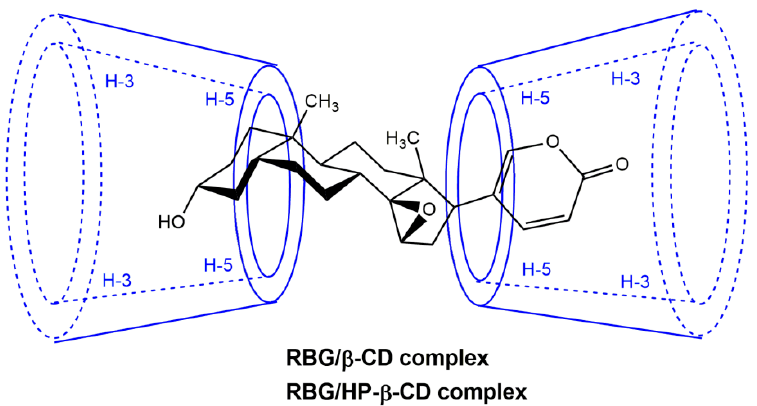
Figure 2. Phase solubility diagrams of RBG/ β -CD and RBG/HP- β -CD system. The CD concentration was in the range of 0–15 mM.